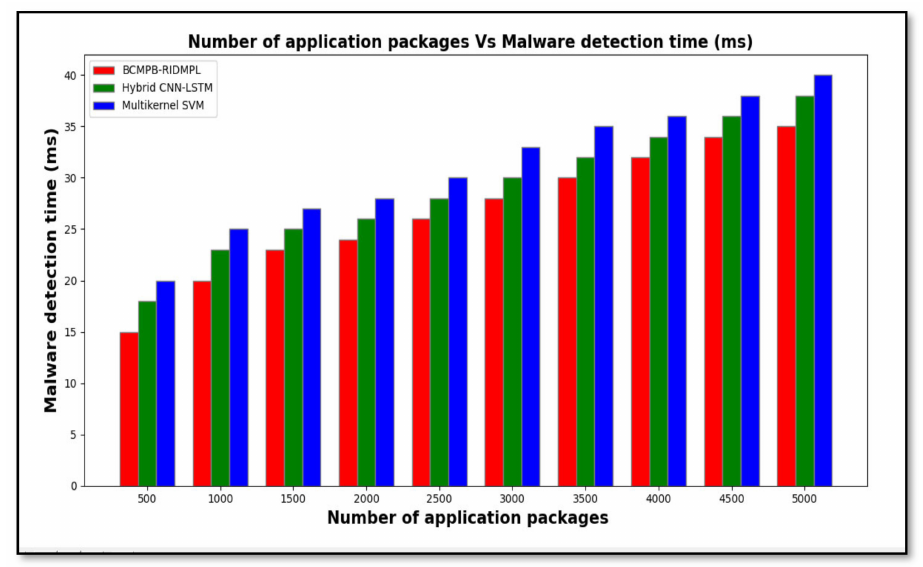
Figure 9. Graphical representation of detection periods of malware for BCMPB-RIDMPL, CNN-LSTM and multi-kernel SVM methods under test. Table 5. Comparison of AUC